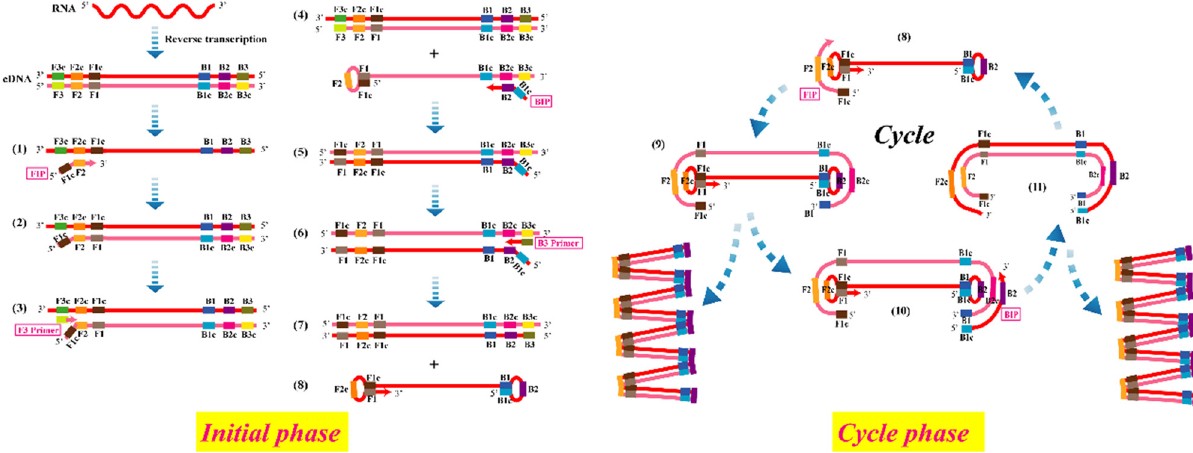
Figure 3: The schematic diagram of RT - LAMP for RNA detection. At the initial phase, cDNA strands formed by reverse transcription are used as templates for initiating reactions. F2 of FIP hybridizes to F2c of template DNA strand, guiding the synthesis of cDNA strand. The F3 primer anneals to the F3c region of template. With the help of DNA polymerase, starting the chain substitution reaction and releasing the FIP - linked complementary strand, double - stranded DNA is synthesized from the F3 primer and the template DNA strand. Because the complementary F1c and F1 regions exist at the chain of 5 ′ end of the released single strand, stem - loop structure is formed by complementary base. And then this single strand is regarded as a template in turn, and under the action of the BIP and B3, another new stem - loop structure at the other end of the DNA is assembled. A dumbbell structure is formed in the initial phase, this structure can serve as the template for cycle ampli fi cation during the subsequent reaction. Then, at the cycle phase, this dumbbell - like DNA structure was assembled repeatedly and ampli fi ed with the participation of FIP and BIP, the fi nal products are stem - loop DNAs with several repeats of target and cauli fl ower - like structures with multiple